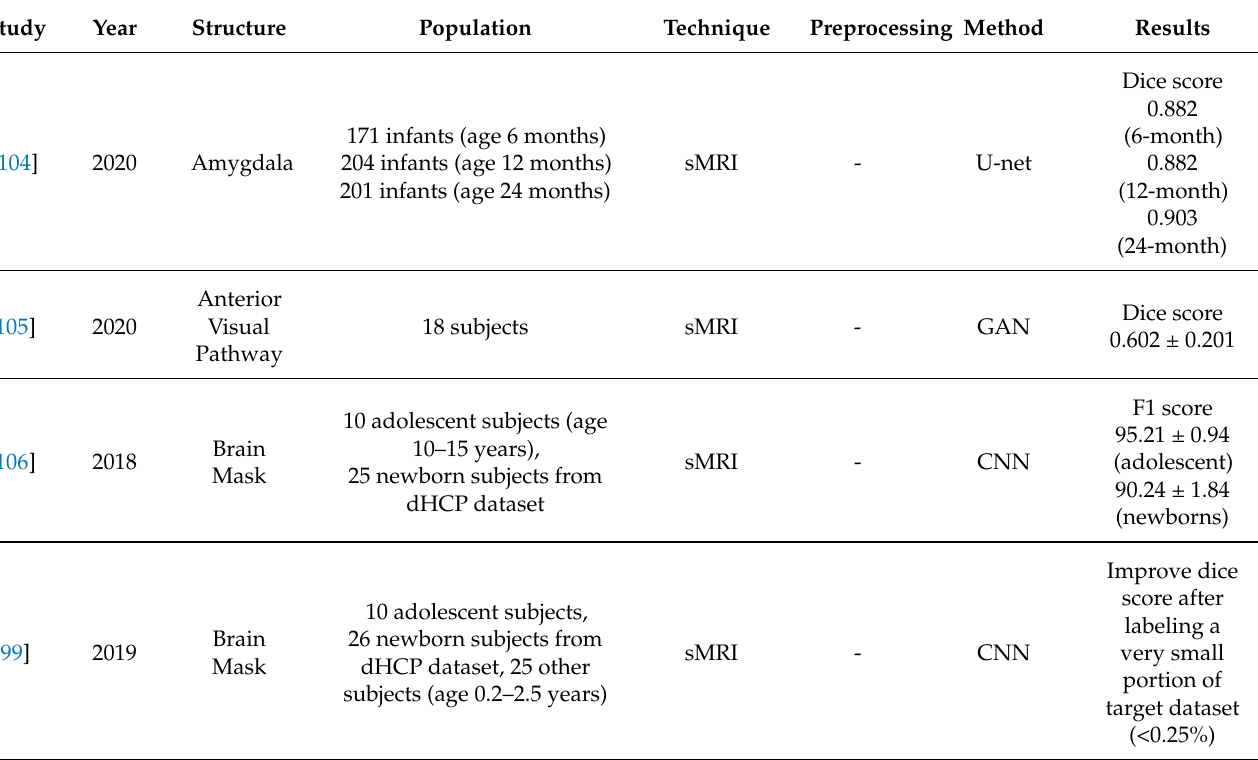
Table 3. Identifying brain and tissue